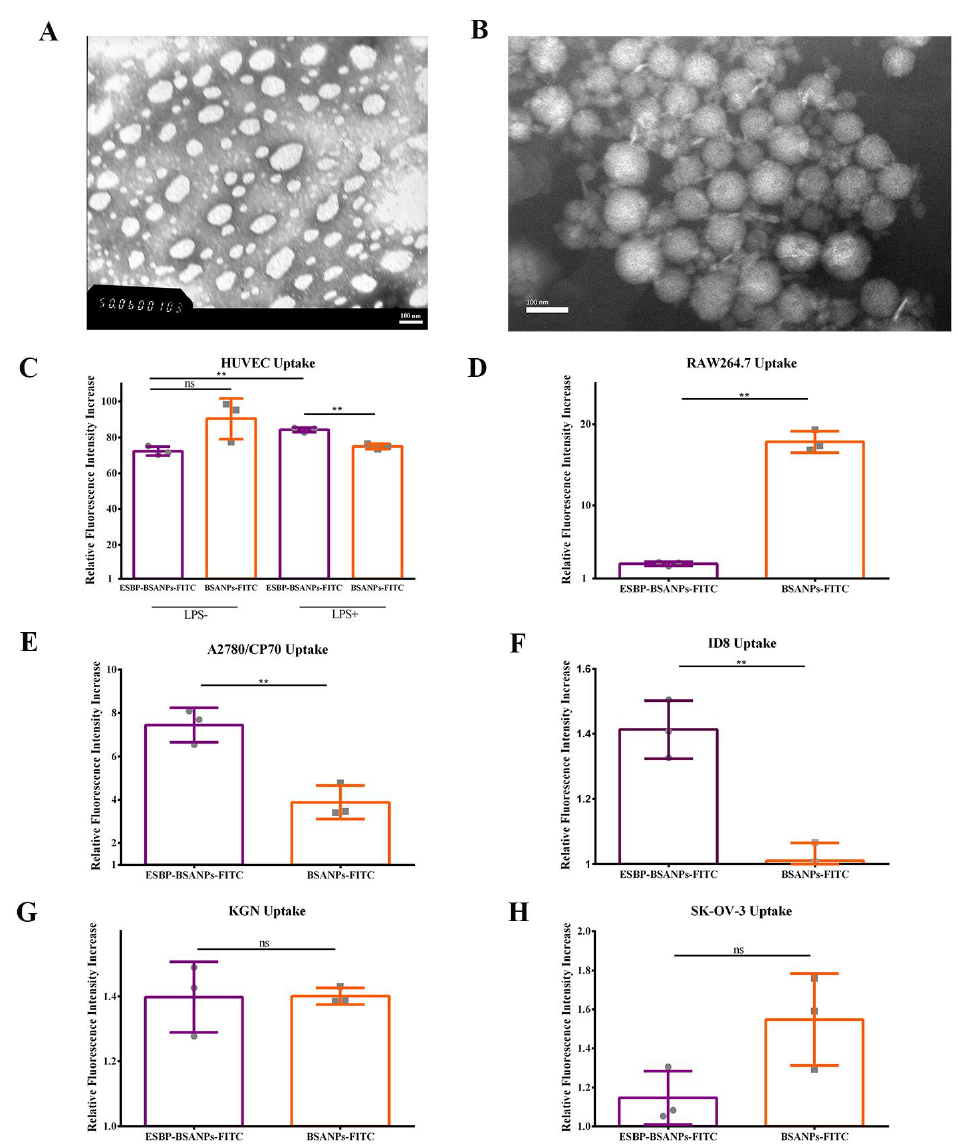
Figure 1. Preparation and characterization of ESBP-BSANPs-PTX. Transmission electron microscope (TEM) images of ( A ) BSANPs-PTX and ( B ) ESBP-BSANPs-PTX (scale bar: 100 nm). The normalized uptake of each cell line (uptake of ESBP-BSANPs-FITC and BSANPs-FITC groups compared with that of free FITC group) (mean ± SD, n = 3). ( C ) HUVEC and ( D ) RAW264.7 cells are E-selectin expressing cells; ( E ) A2780/CP70 and ( F ) ID8 are CD44 low-expression cells, ( G ) KGN and ( H ) SK-OV-3 are CD44 high-expression cells. ns represents p > 0.05, ** p < 0.01.